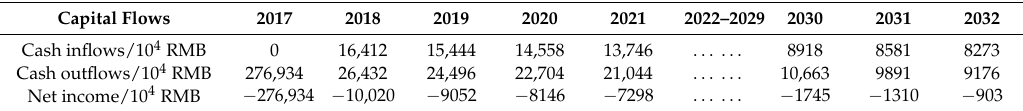
Table 5. The cash flow statement of the demonstration project phase.